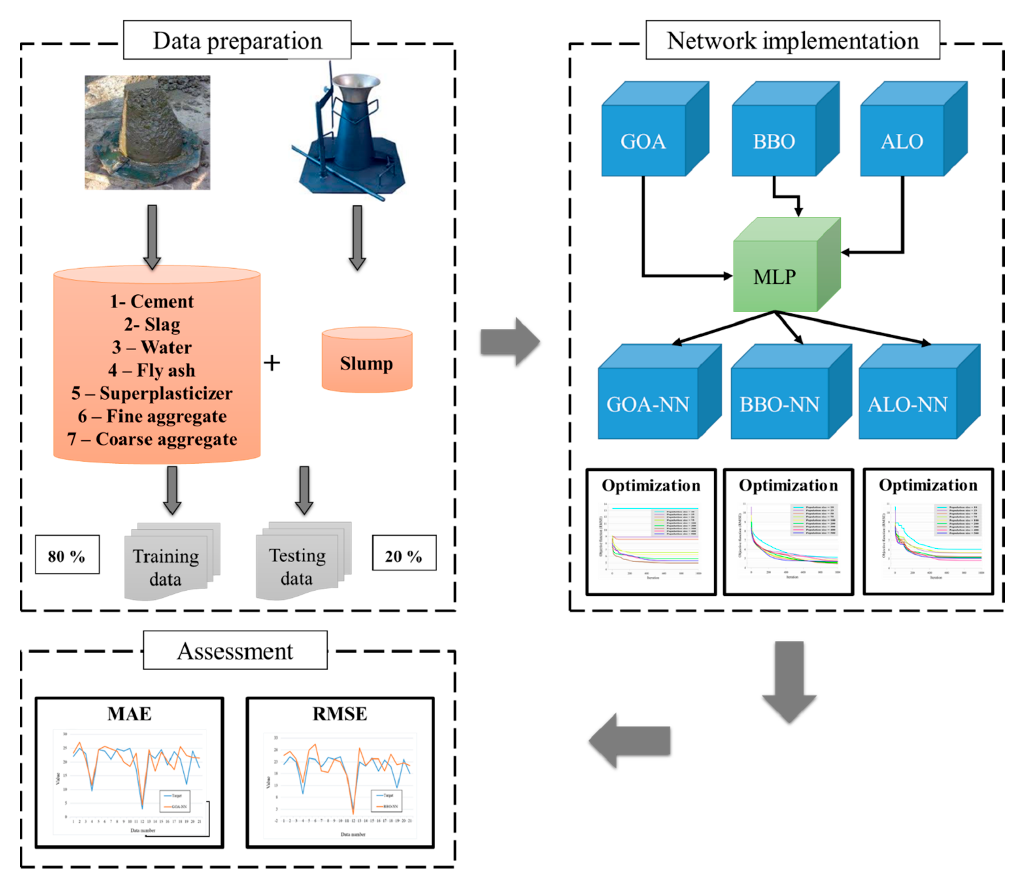
Figure 1. The graphical methodology of the present ant lion optimization (ALO)-based study.